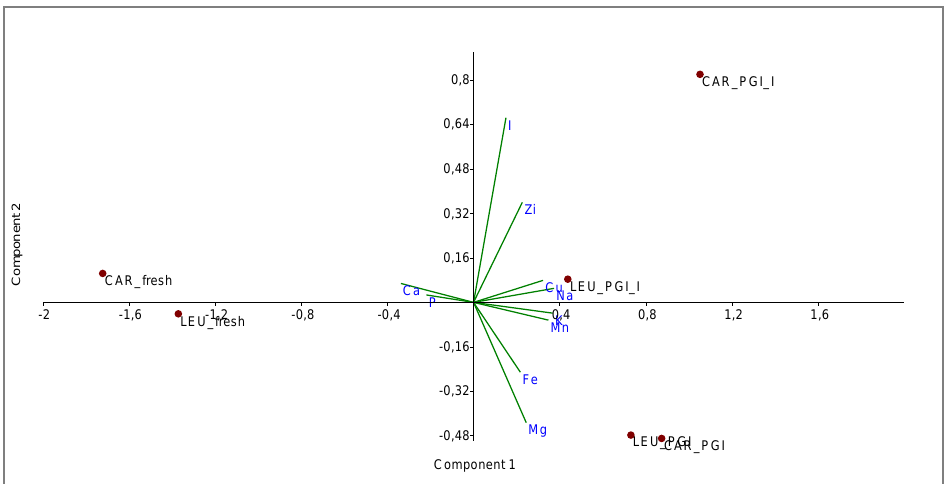
Figure 3. Bi -plot obtained by PCA of data-set based on mineral composition. CAR_fresh: Carolea fresh, LEU_fresh: Leucocarpa fresh; CAR_PGI: Carolea fermented in PGI sea salt; LEU_PGI: Leucocarpa fermented in PGI sea salt; CAR_PGI_I: Carolea fermented in PGI iodized sea salt; LEU_PGI_I: Leucocarpa fermented in PGI iodized sea salt.